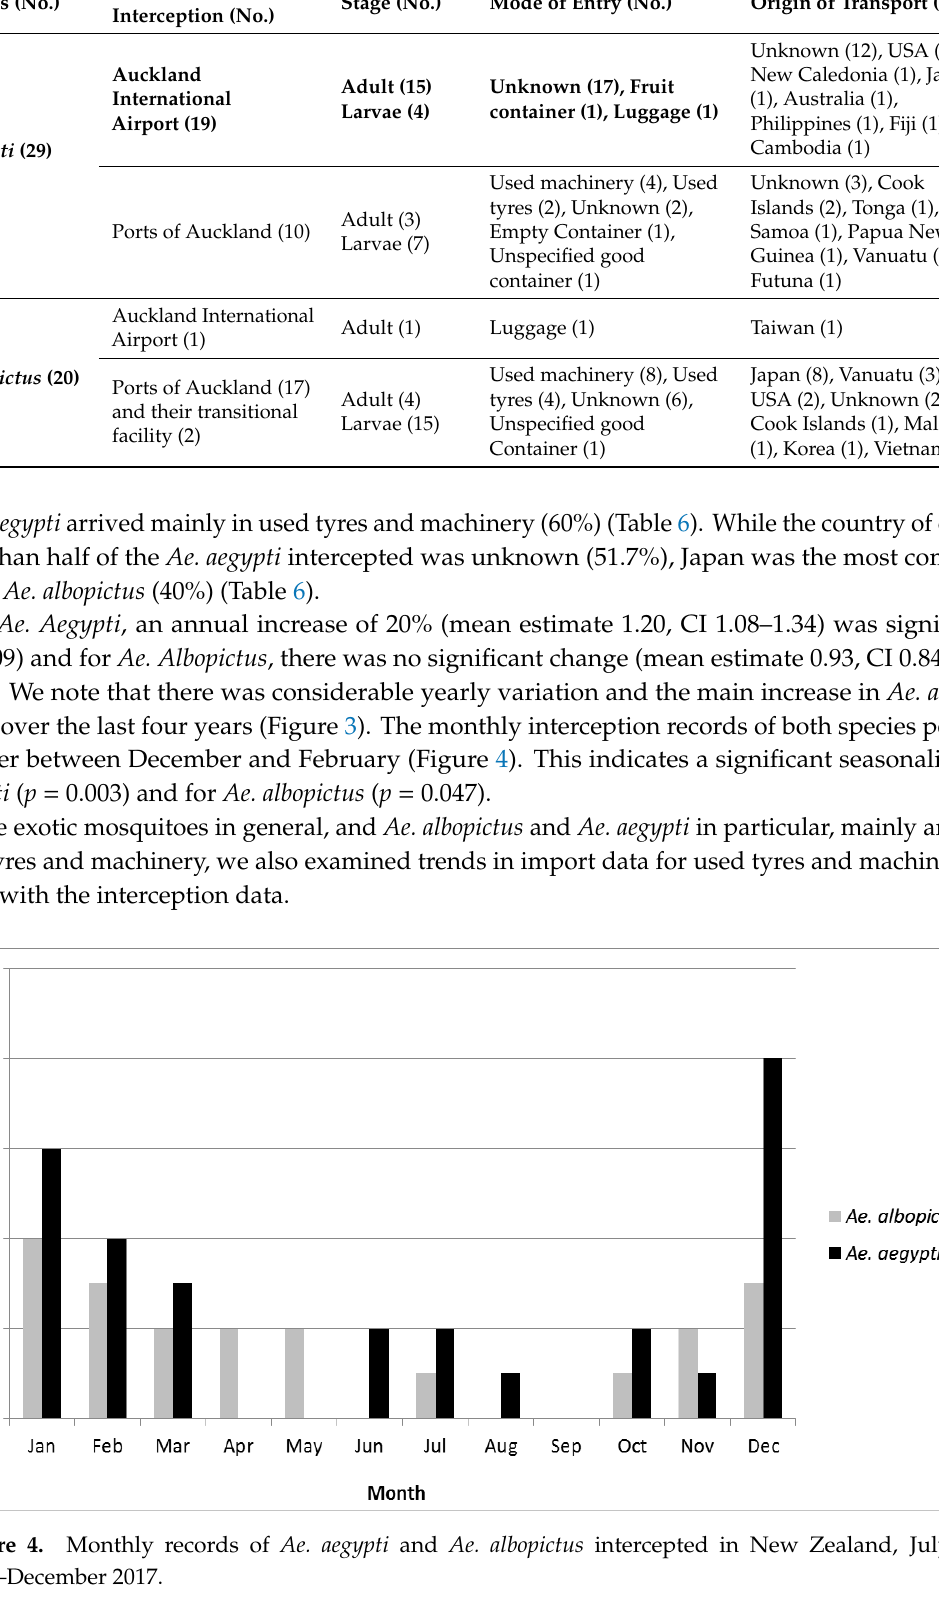
Table 6. Origin of Ae. aegypti and Ae. albopictus intercepted in New Zealand, July 2001–March 2018. Species (No.)